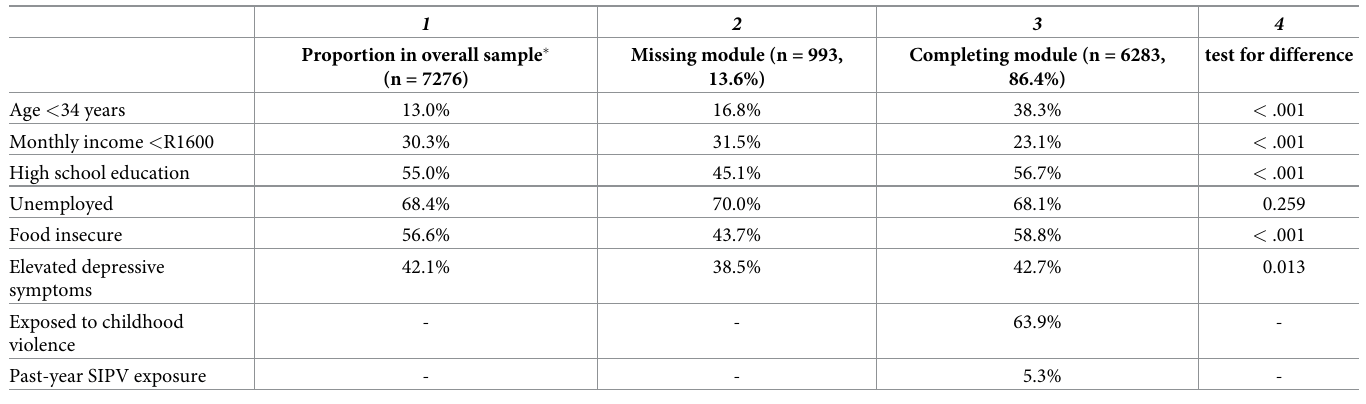
Table 1. Descriptive statistics of women in the survey (n =